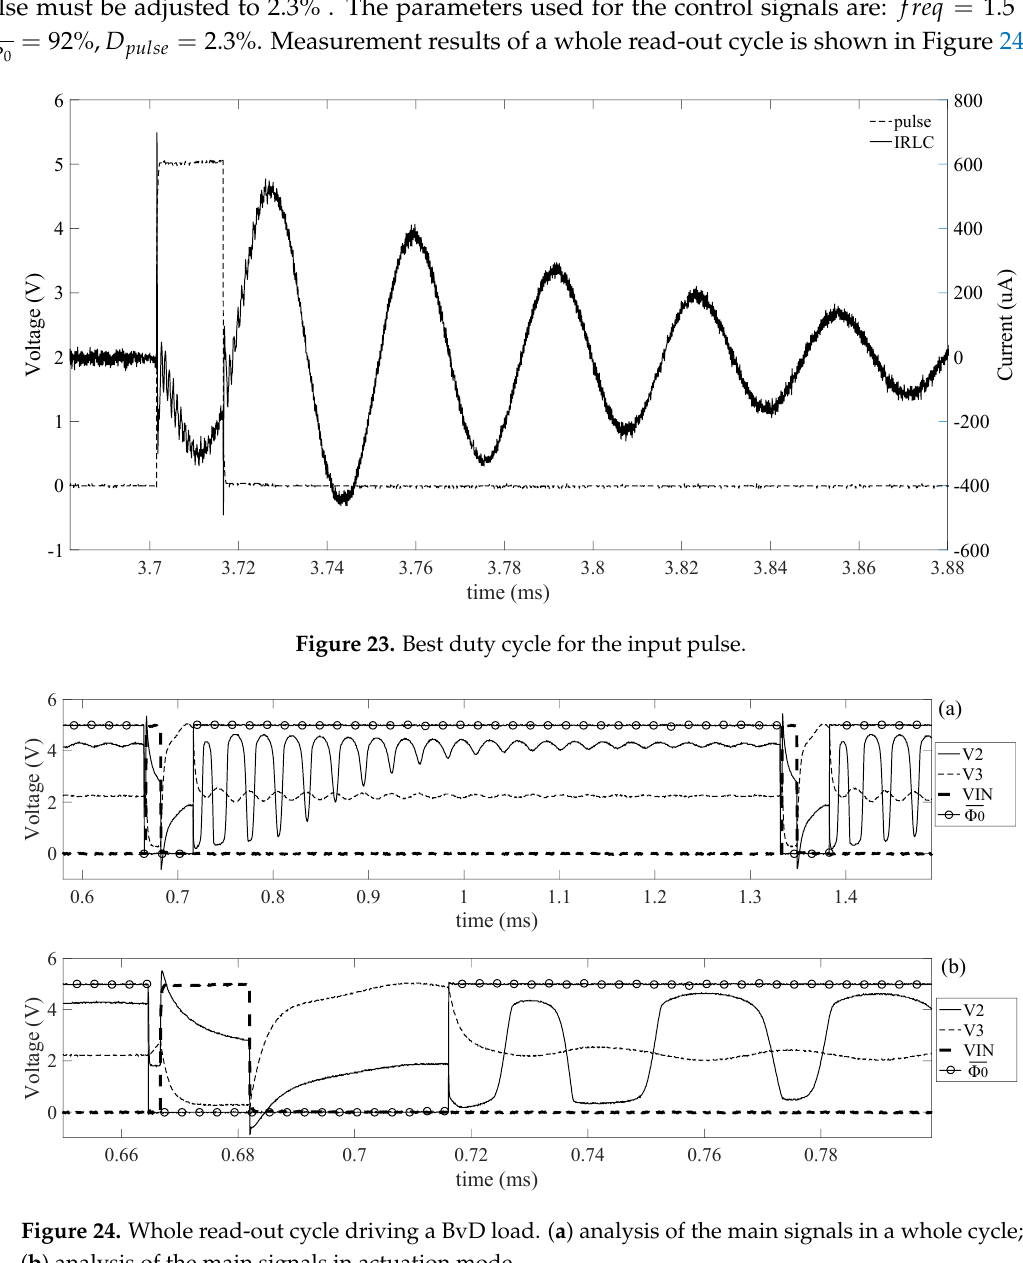
Figure 24. Whole read-out cycle driving a BvD load. ( a ) analysis of the main signals in a whole cycle; ( b ) analysis of the main signals in actuation